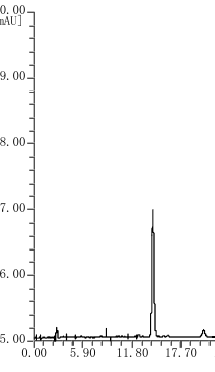
Figure 5. HPLC chromatograms of the black rice extracts.